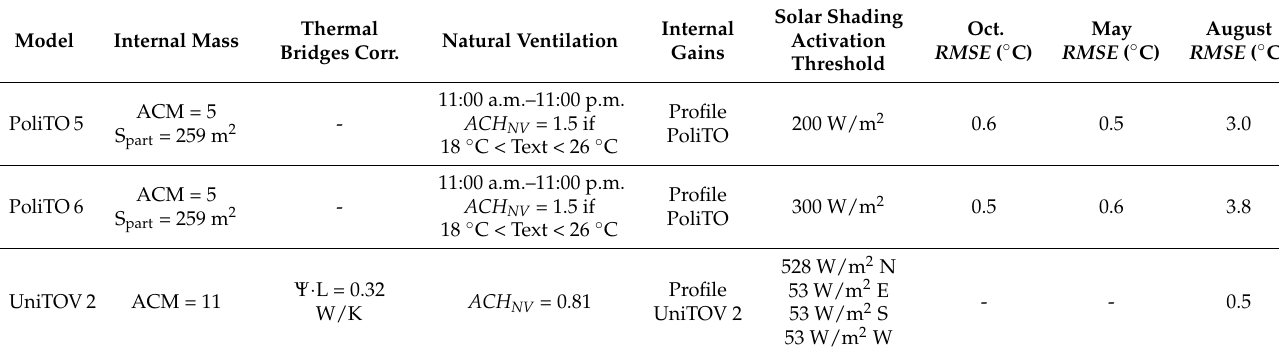
Table 9. Performance of the revised